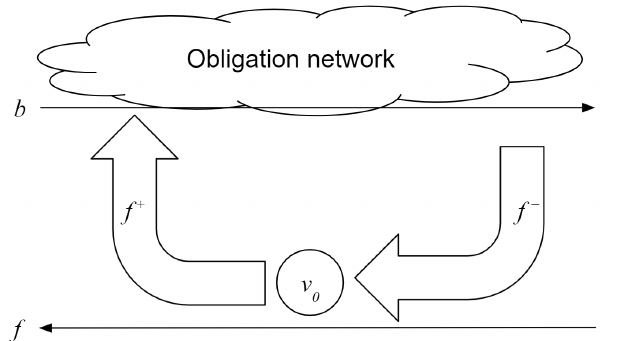
Figure 2. Payment system: obligation network, liquidity source/sink v 0 , and vectors representing